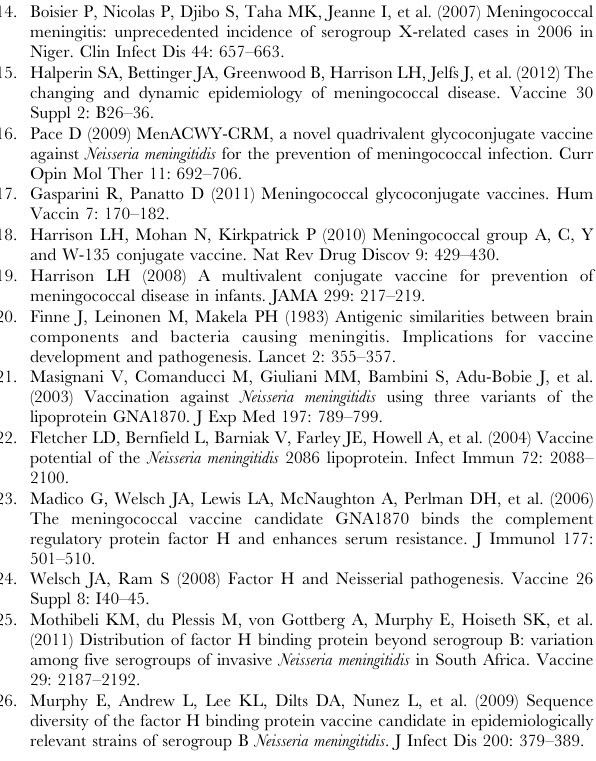
Figure S2 Detection of major proteins in NOMV vaccines. Major proteins in NOMV vaccines as visualized by Coomassie-stained SDS-PAGE. rfHbp, recombinant fHbp ID 9 control. OE, NOMV-fHbp vaccine with over-expressed R41S mutant fHbp prepared from the mutant vaccine strain with D lpxl1 and D capsule; KO, NOMV prepared from a triple knockout